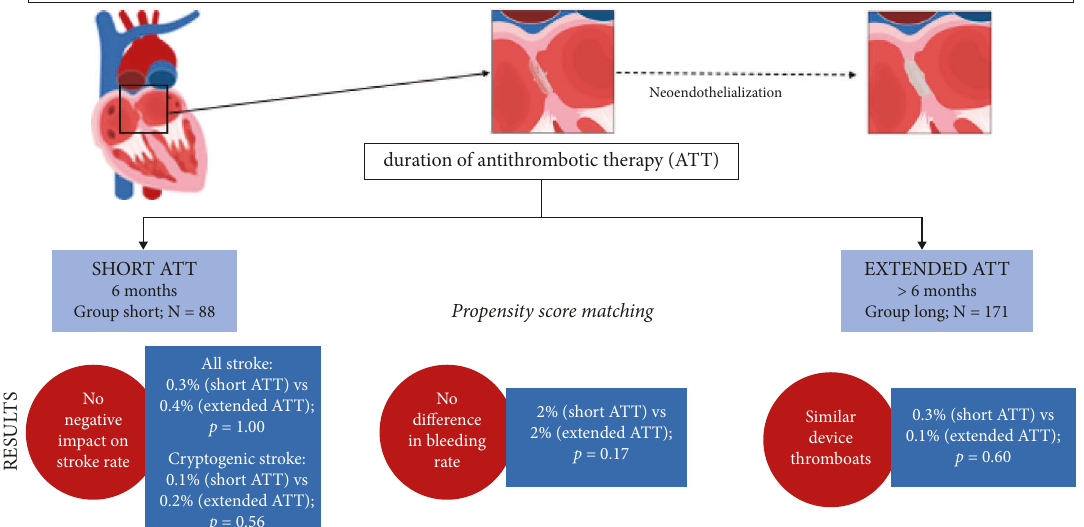
Figure 4: Central illustration. PFO closure to prevent recurrent cryptogenic stroke: Overview of the study methodology and main results. PFO, patent foramen ovale; ATT, antithrombotic